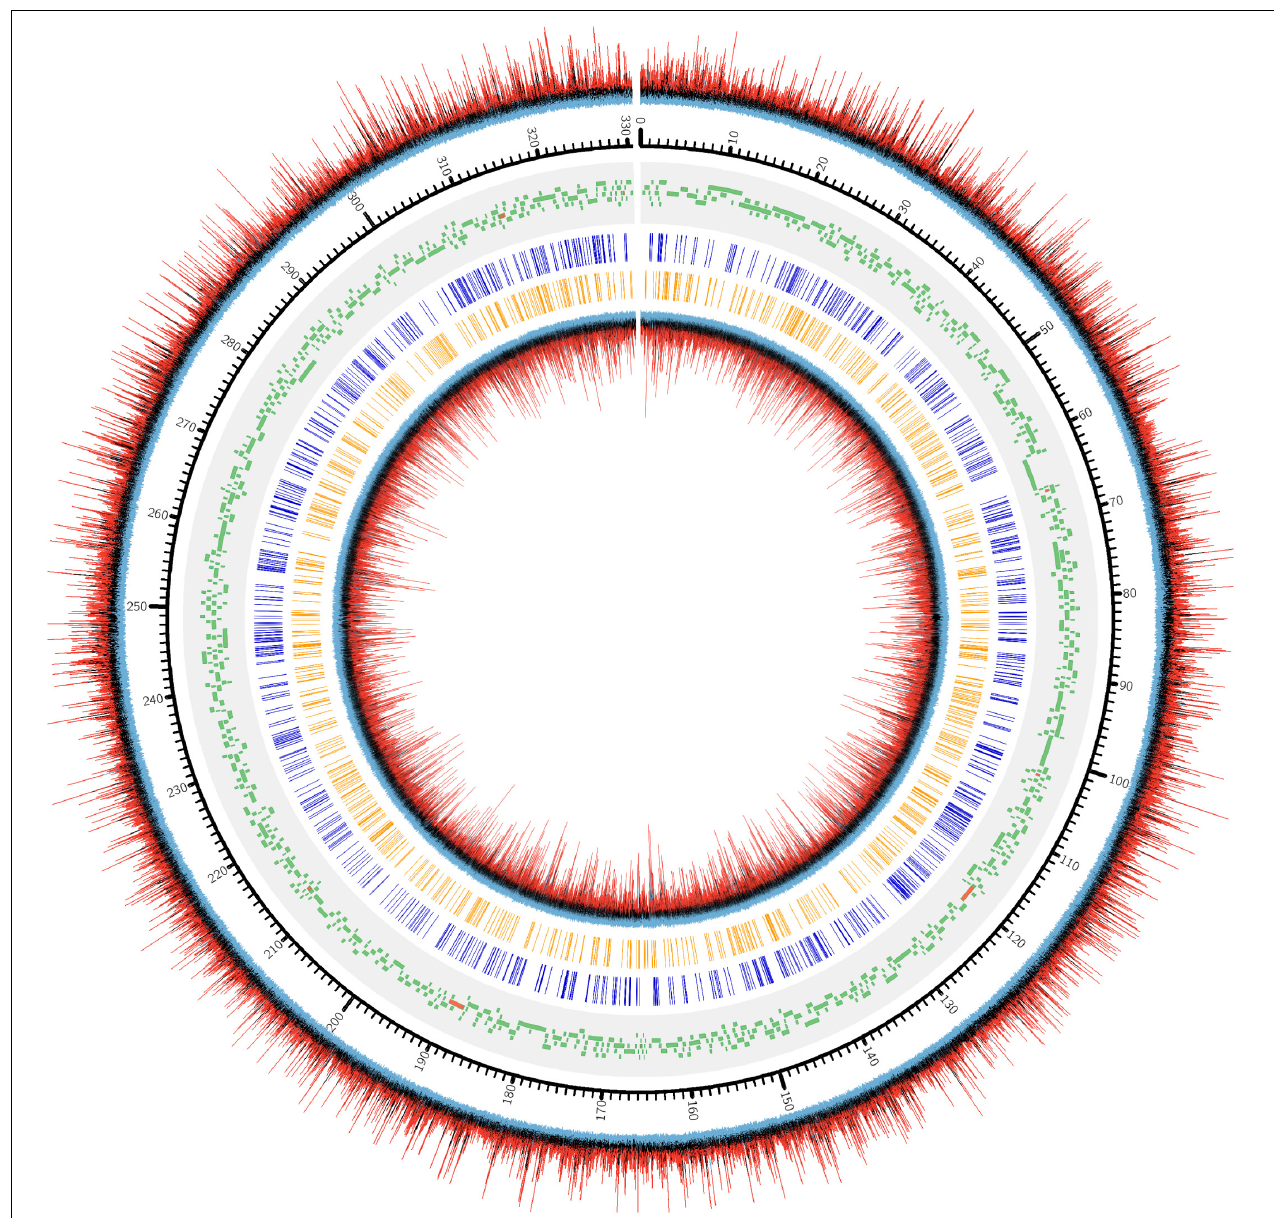
FIGURE 2 | DNA modification induced kinetic events encountered during SMRT sequencing of one PBCV1 replicate (PBCV1-1C, Supplementary Figure S1 ). Starting from the outermost ring and going inward: (1) ipdRatio for each nucleotide on the forward strand, (2) genomic positions for PBCV-1 (kbp), 3) PBCV-1 potential protein coding sequences and tRNA encoding sequences (Dunigan et al., 2012), (4) CATG sites, (5) GATC sites, and (6) ipdRatio for each nucleotide on the reverse strand. The color coding of the ipdRatio is artificial to denote peak values, with a red peak denoting a value > 2. Black peaks indicate nucleotide kinetics similar to a non-modified base (ipdRatio ∼ 1), and blue peaks indicate a value < 0.5. This plot was made in CIRCOS (Krzywinski et al., 2009) with the intent of displaying ipdRatio peak height occurrence and diversity. The sequenced replicates exhibited CIRCOS plots with nearly imperceptible differences, which is why only one representative is shown